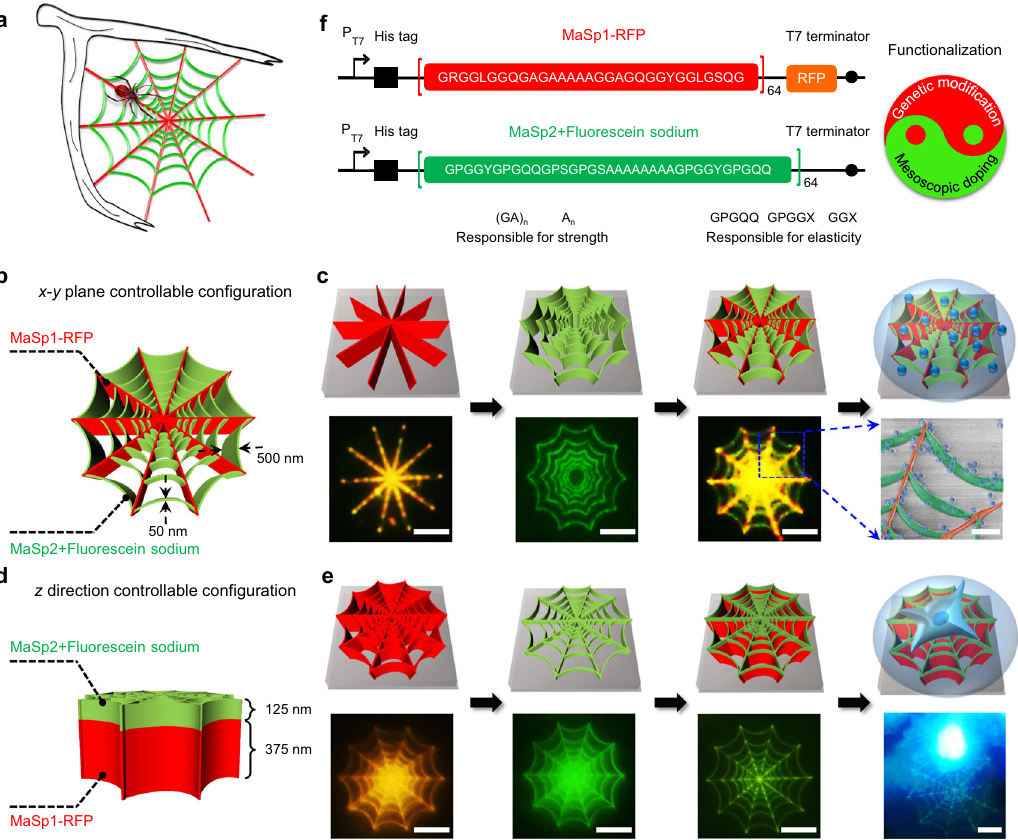
Fig. 3 Heterogeneous, hierarchical, biomimetic 3d nanostructures using functionalized recombinant spider silk proteins. a Schematic representation of a natural spider web with heterogeneous and hierarchical structures. b , c x – y plane controllable con fi guration of spider nanowebs for PMMA nanospheres (~250 nm in diameter) selective adhesion. Scale bars in ( c ), fl uorescence microscope photographs (lower left 3 images), 5 μ m; false-color SEM image (lower right), 1 μ m. d , e z direction controllable con fi guration of spider nanowebs for single brain tumor cell (~30 μ m in diameter) adhesion. Scale bar in ( e ), fl uorescence microscope photographs (lower row), 10 μ m. f Genetically engineered spider silk proteins functionalized with RFP (red fl uorescent protein) and fl uorescein sodium. R: Arginine. S: Serine. P: